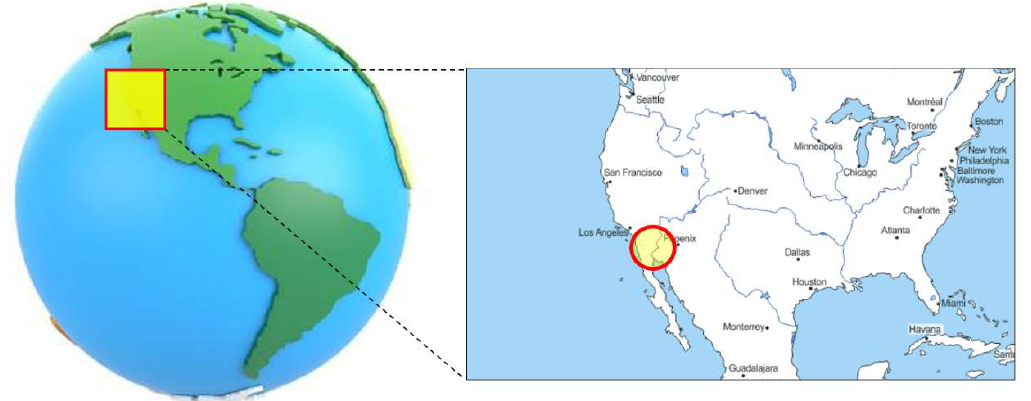
Figure 4. Geographical location of the study area.